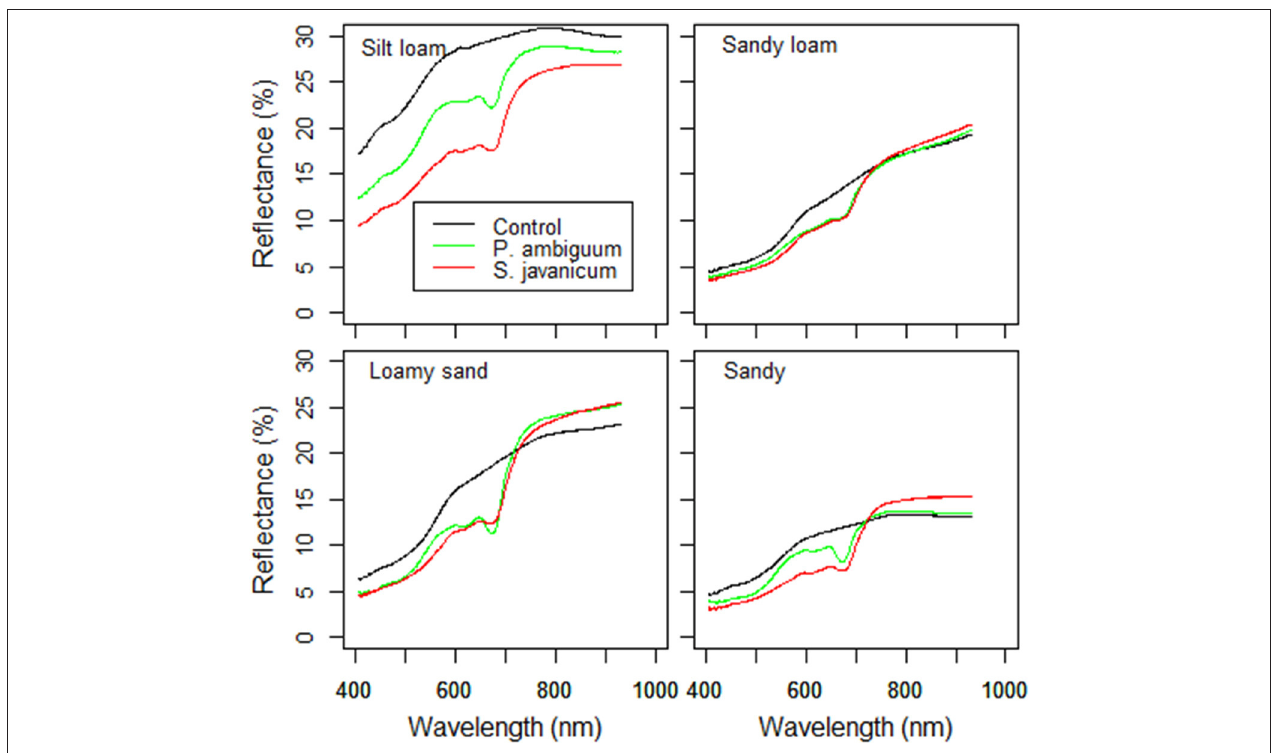
FIGURE 4 | Surface reflectance of control and inoculated soils at the end of the incubation period (90 days).